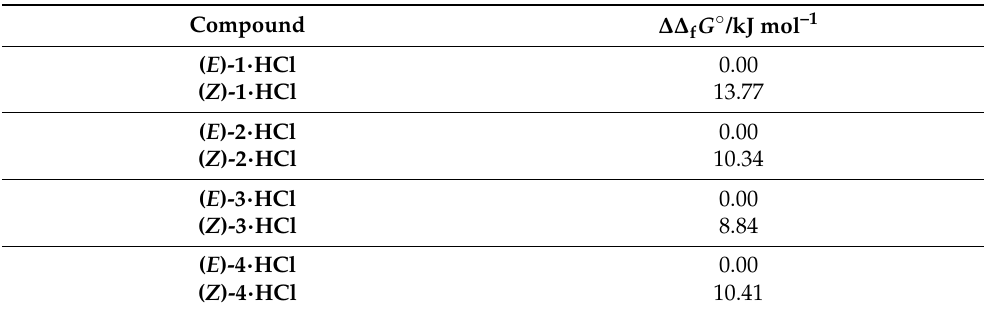
Figure 11. Four lowest energy conformers of RI4 and their relative standards Gibbs energies of formation ∆ f G ◦ calculated at the B3LYP-D3/6-311++G(d,p) level of the theory. (Relative fractions according to Boltzmann distribution at 298.15 K are given in blue.) Table 4. Calculated differences of standard Gibbs energies of formation ∆∆ f Gº relative to the ( E )- isomers for hydrochlorides 1 – 4